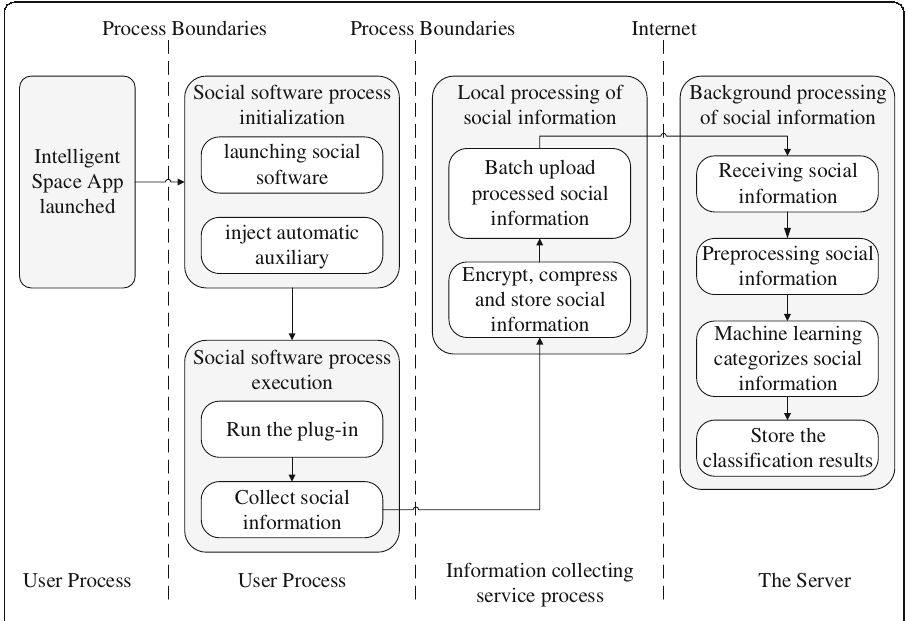
Fig. 2 Key flow chart of data acquisition